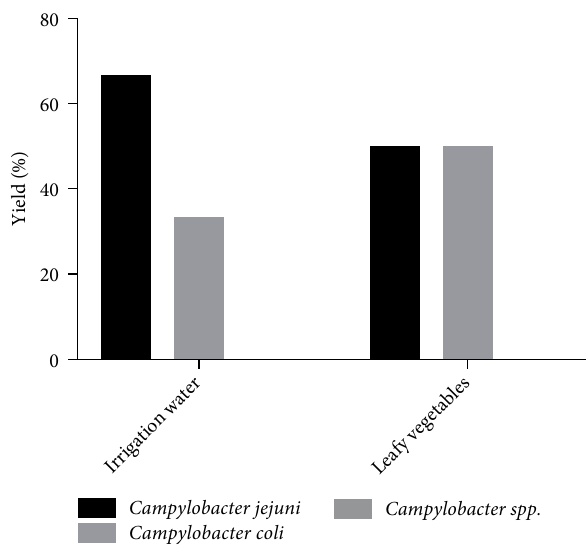
Figure 4: Distribution of Campylobacter species according to contaminated samples from NPK